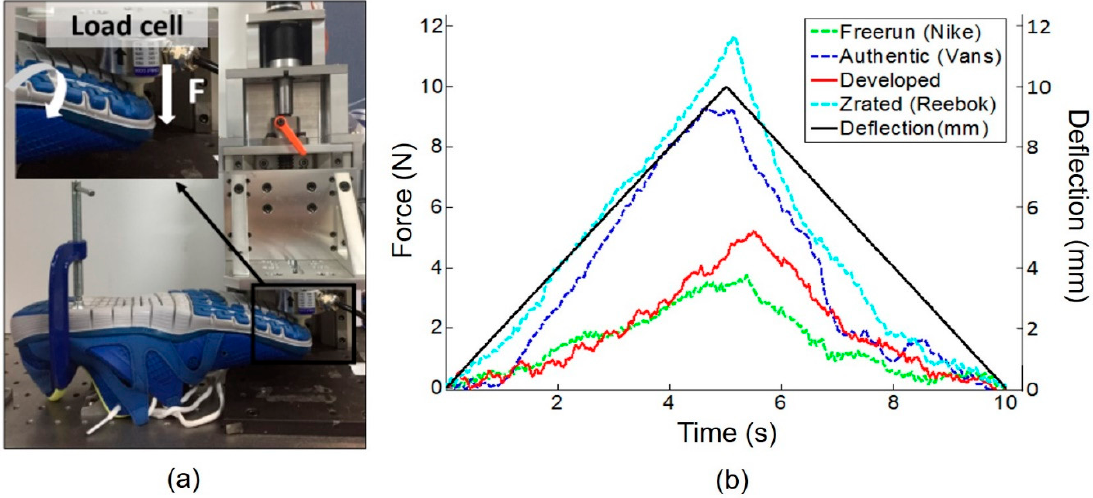
Figure 7. Forefoot bending sti ff ness test results. ( a ) Experimental setup for the forefoot bending sti ff ness test. ( b ) Results of the forefoot bending sti ff ness tests for three commercial shoes with the developed GRF measurement system: Right y -axis means the deflection of the load cell and black solid line indicates the imposed deflection of the load cell. Left y -axis means the force measured by the load cell and other lines except the black solid line represent the force measured for the commercial shoes.